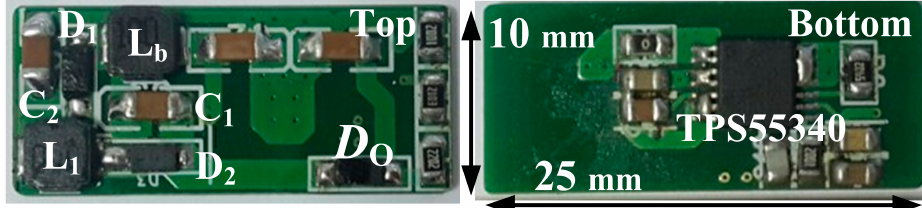
Figure 7. Photograph of the proposed DC-DC boost converter. Table 1. Component values for the experimental boost converters.